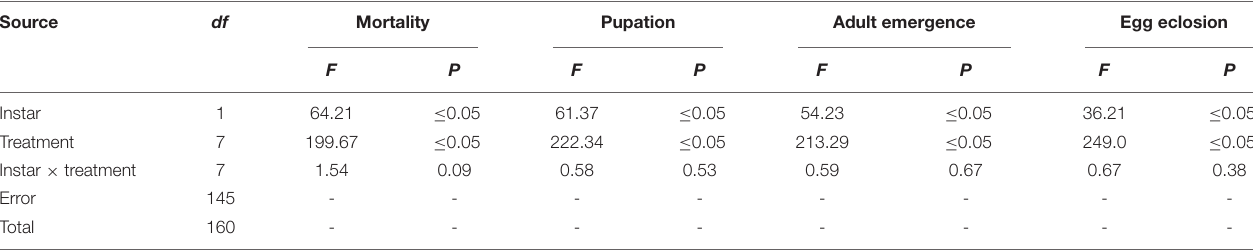
TABLE 1 | Factorial analysis of mortality, pupation, adult emergence and egg eclosion of H. armigera treated with endophytically colonized B. bassiana and B. thuringiensis. Source df Mortality Pupation Adult emergence